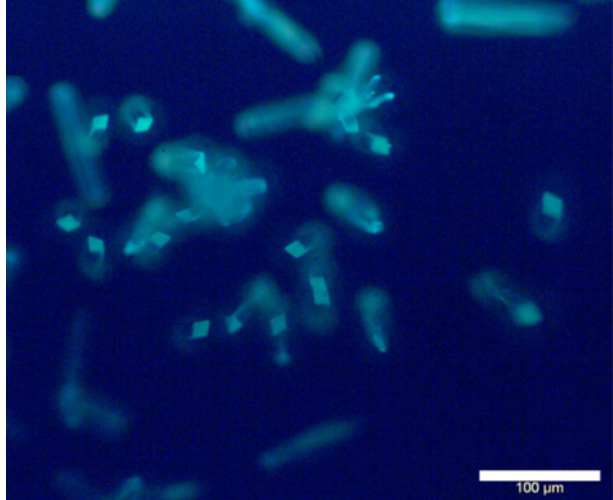
Figure 7. Fluorescence microscope image of Zn(ADC)·DMSO